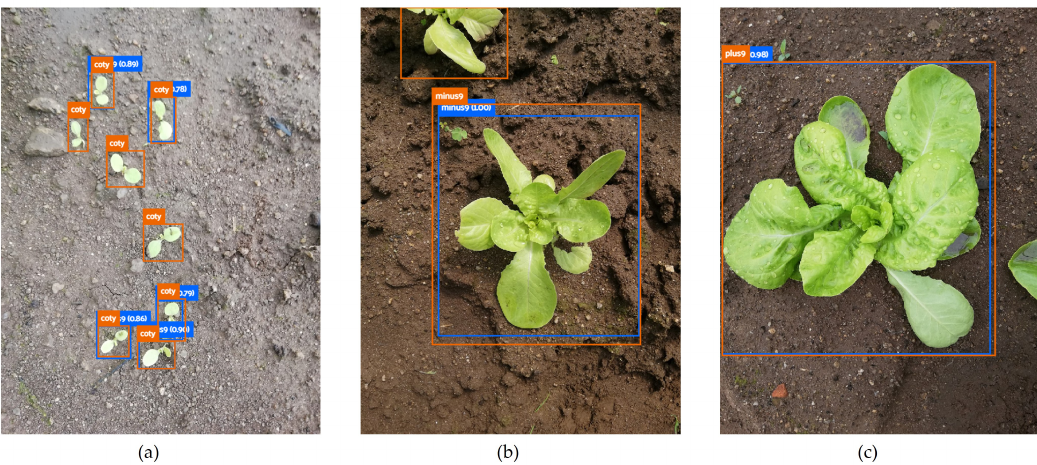
Figure 8. Lettuce phenophases: ( a ) coty (opened cotyledons); ( b ) minus9 (less than nine unfolded leaves); ( c ) plus9 (nine or more unfolded leaves).